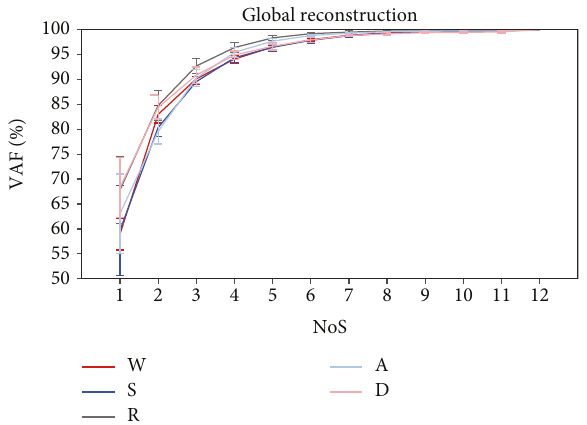
Figure 3: Mean and standard deviation of the VAF subjects as function of the number of muscle synergies for each